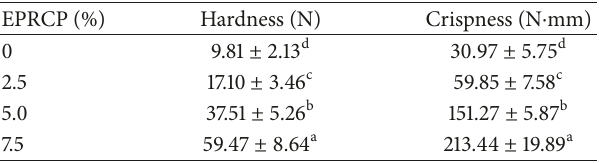
Table 4: Texture ∗ of extrudates using encapsulated powder of red cactus pear (EPRCP) as